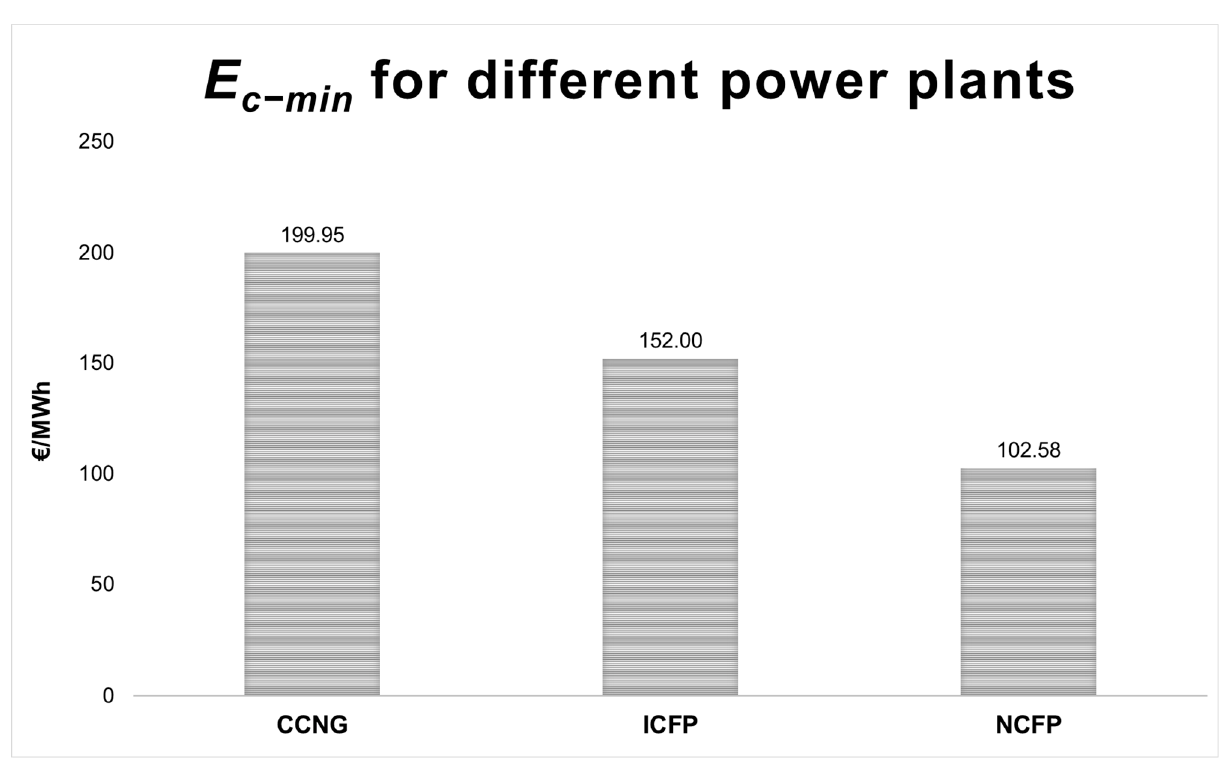
Figure 5. Minimum offer price for different